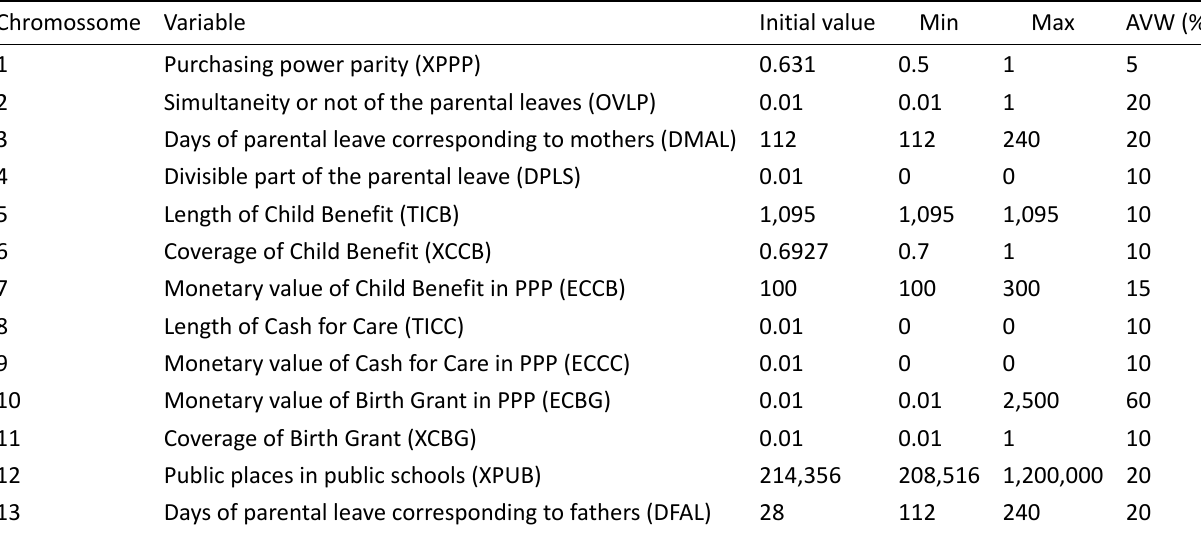
Table 2. Reference values for the